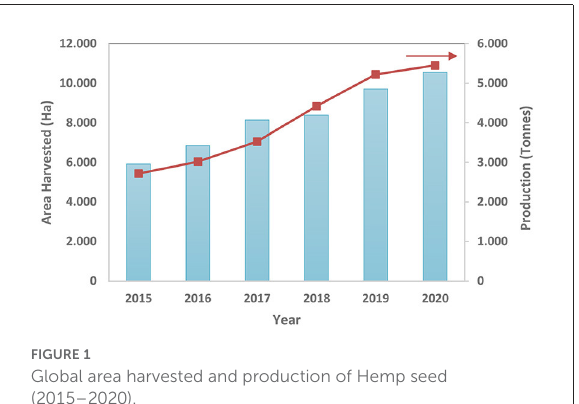
FIGURE1 Global area harvested and production of Hemp seed (2015–2020).